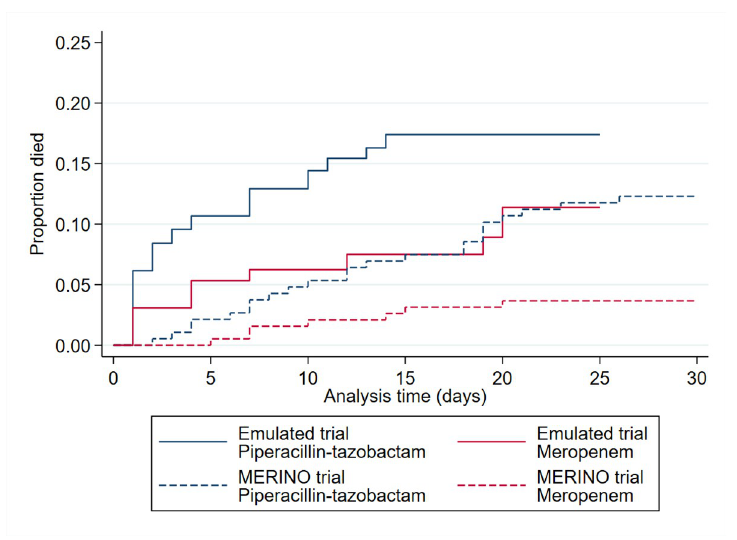
Fig 1. Inverse probability weighted Kaplan-Meier, by emulated